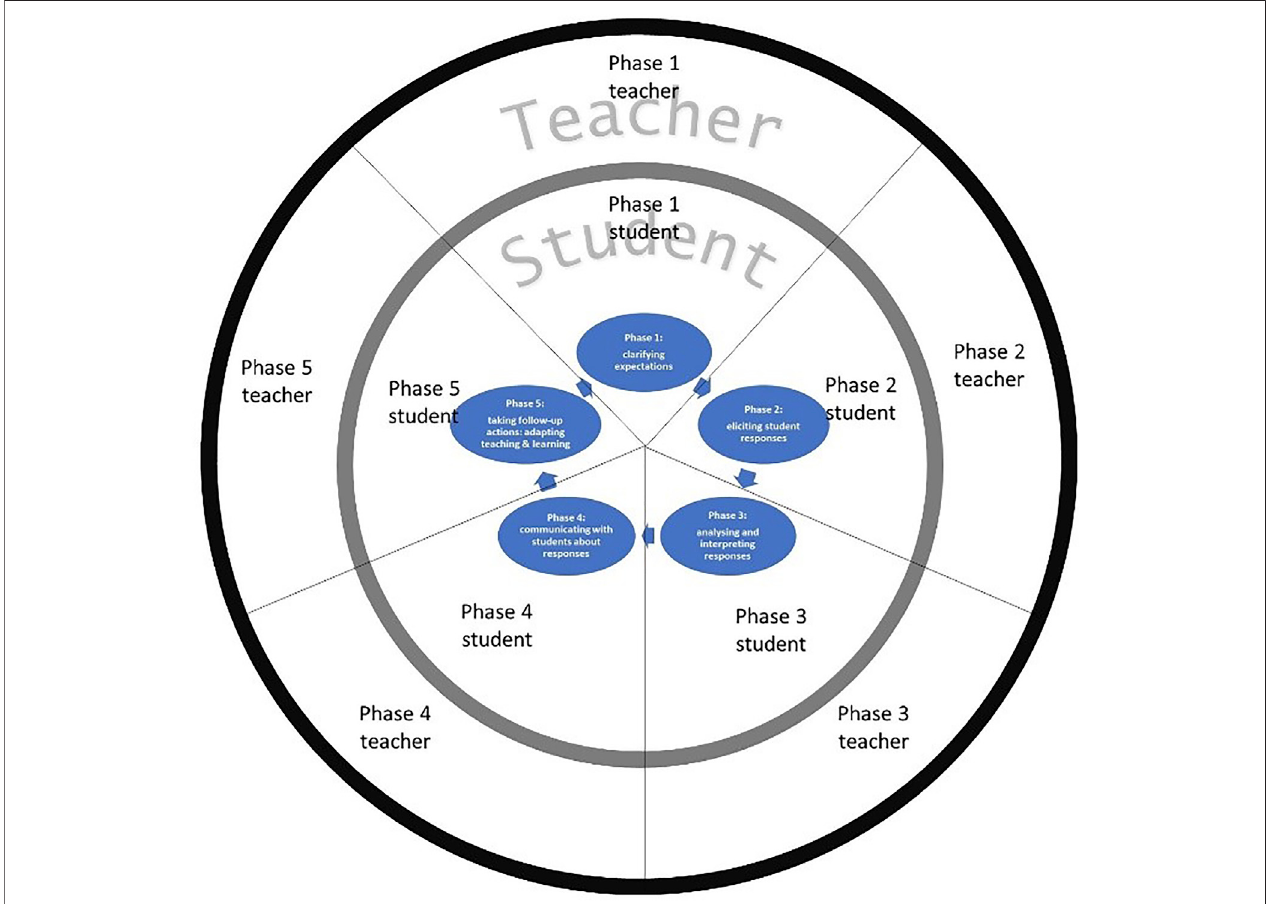
FIGURE 2 | The student-teacher co-regulatory formative assessment cycle